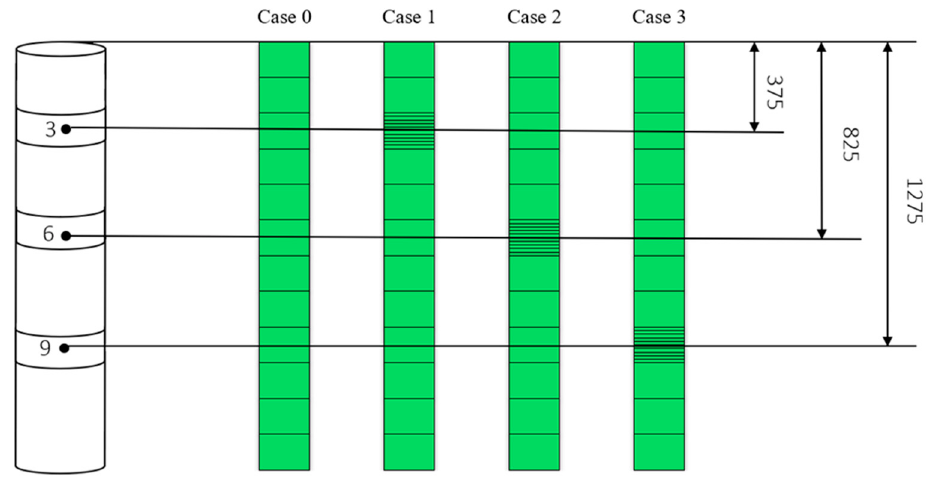
Figure 10. Reference node splitting for the investigation of the influence that node volume plays on model accuracy (heights in millimeters).